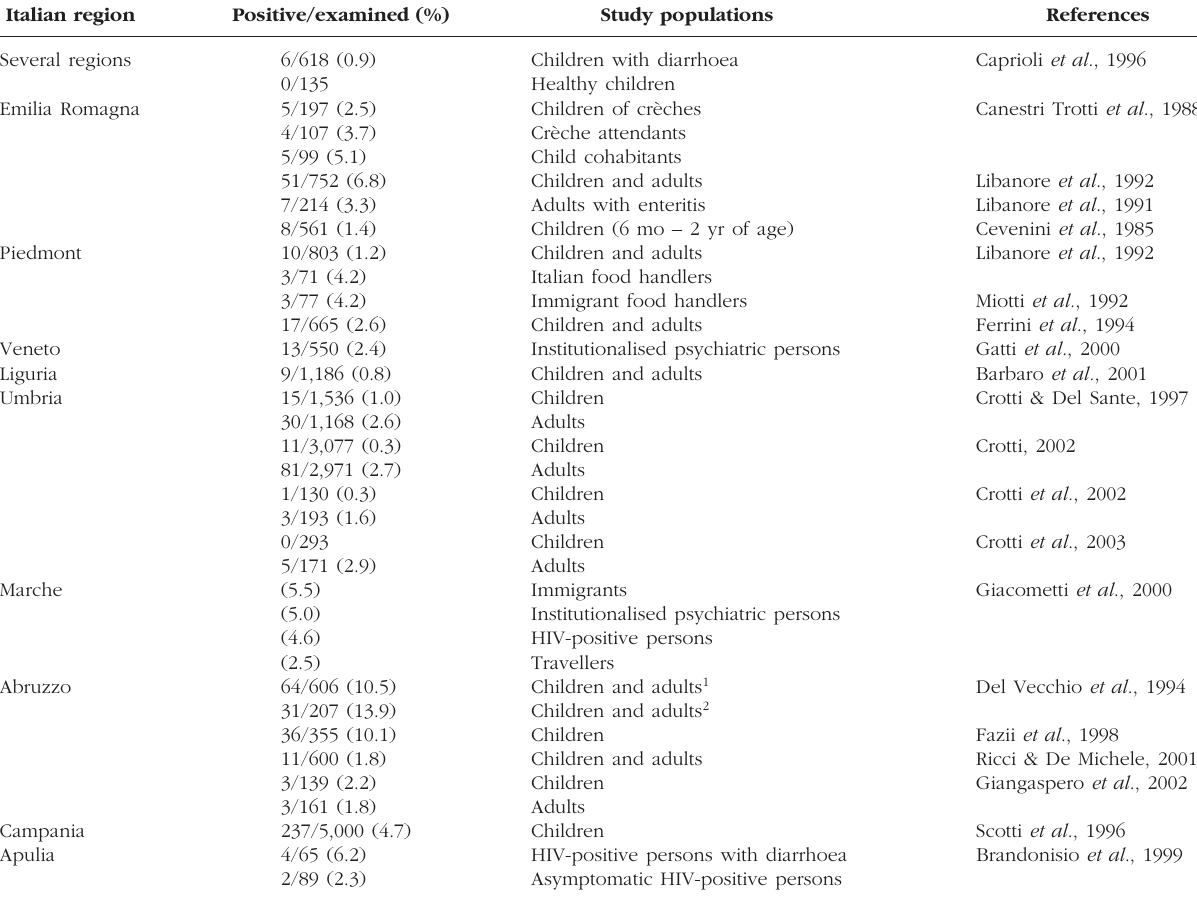
Table III. – Prevalence of Giardia duodenalis in different categories of children and adults according to epidemiological survey carried out in Italy from 1983 to